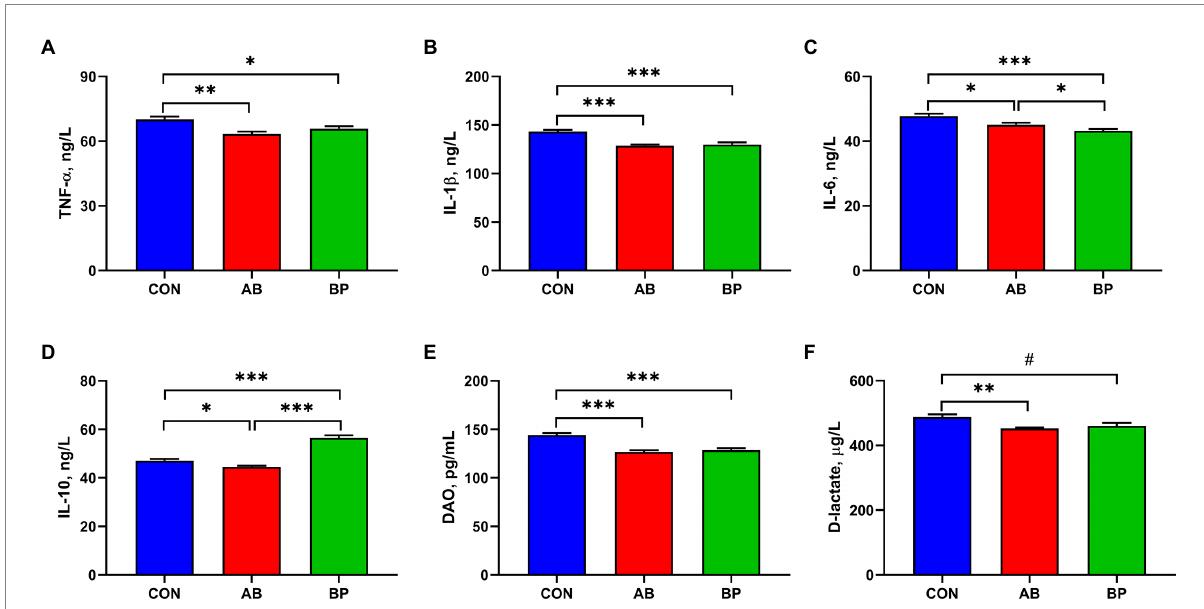
FIGURE 1 Effects of dietary supplemented with Bopu powder on serum inflammatory factors, diamine oxidase (DAO), and D-lactate in broiler chickens. (A) Tumor necrosis factor- α (TNF- α ); (B) Interleukin-1 β (IL-1 β ); (C) Interleukin-6 (IL-6); (D) Interleukin-10 (IL-10); (E) DAO; and (F) D-lactate. CON group, broiler chickens fed a basal diet; AB group, broiler chickens fed a basal diet supplemented with 50 mg/kg aureomycin; and BP group, broiler chickens fed a basal diet supplemented with 40 mg/kg Bopu powder containing protopine and allocryptopine. Values are mean ± SE ( n =